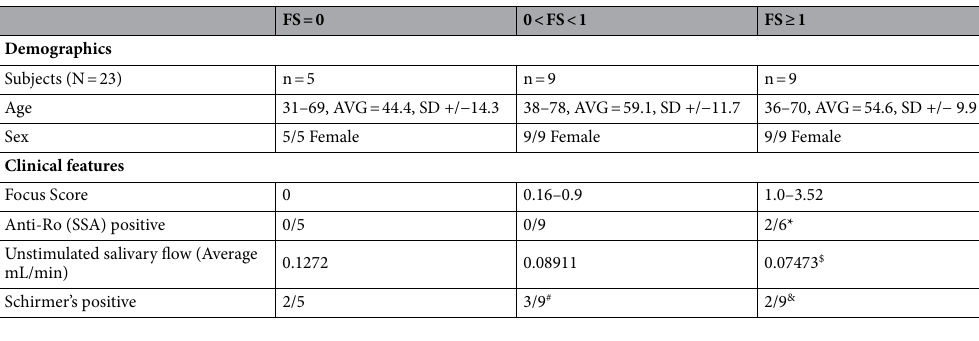
Table 1. Demographics and clinical features of xerostomic patients from whom primary SGEC cultures were derived. Salivary gland epithelial cell cultures (SGECs) were derived individually (not pooled) from a total of N = 23 patients receiving labial salivary gland biopsies as part of the routine diagnostic approach following the 2016 ACR-EULAR classification criteria. Patients were subdivided into three separate groups by focus score (FS) for comparisons (FS = 0, 0 < FS < 1, and FS ≥ 1). All SGEC cultures in this study were derived from female patients and treated identically following the same procedure. The presence of Anti-Ro (SSA) serum was not determined/ tested for in three FS ≥ 1 patients. Of the remaining six FS ≥ 1 patients, only two were positive ( +) for the presence of serum Anti-Ro (SSA). $ One patient with focus score of 1.3 but negative Schirmer’s test, and unstimulated salivary flow of 0.332 mL/min was excluded from average calculation. Status was unavailable, due to lack of test or non-consent: *three patients; # three patients; & one